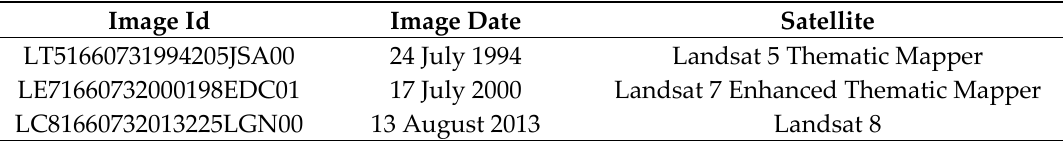
Table 1. Landsat images selected for the land cover change analysis.